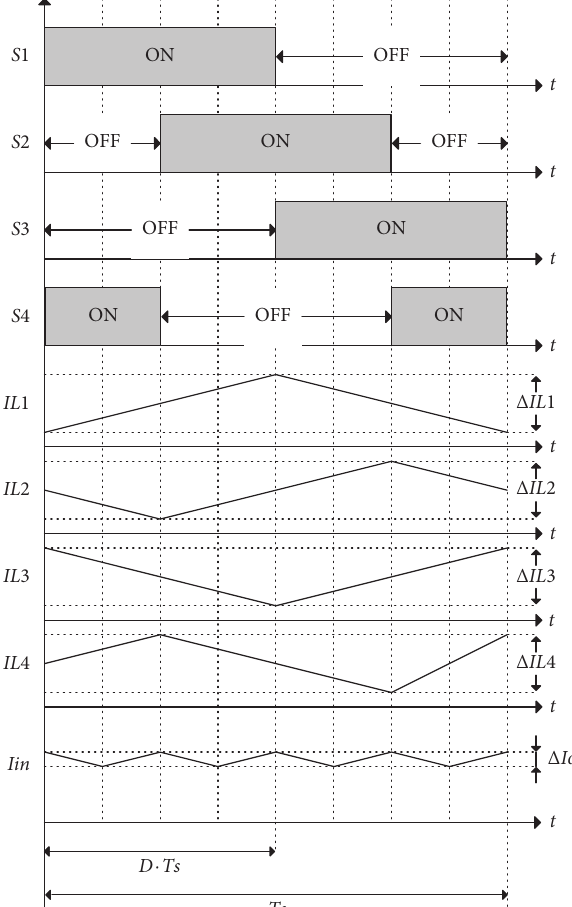
Figure 4: Switching pattern and inductor current waveform in range of duty ratio as 1/4. Figure 5: Switching pattern and inductor current waveform in range of duty ratio as